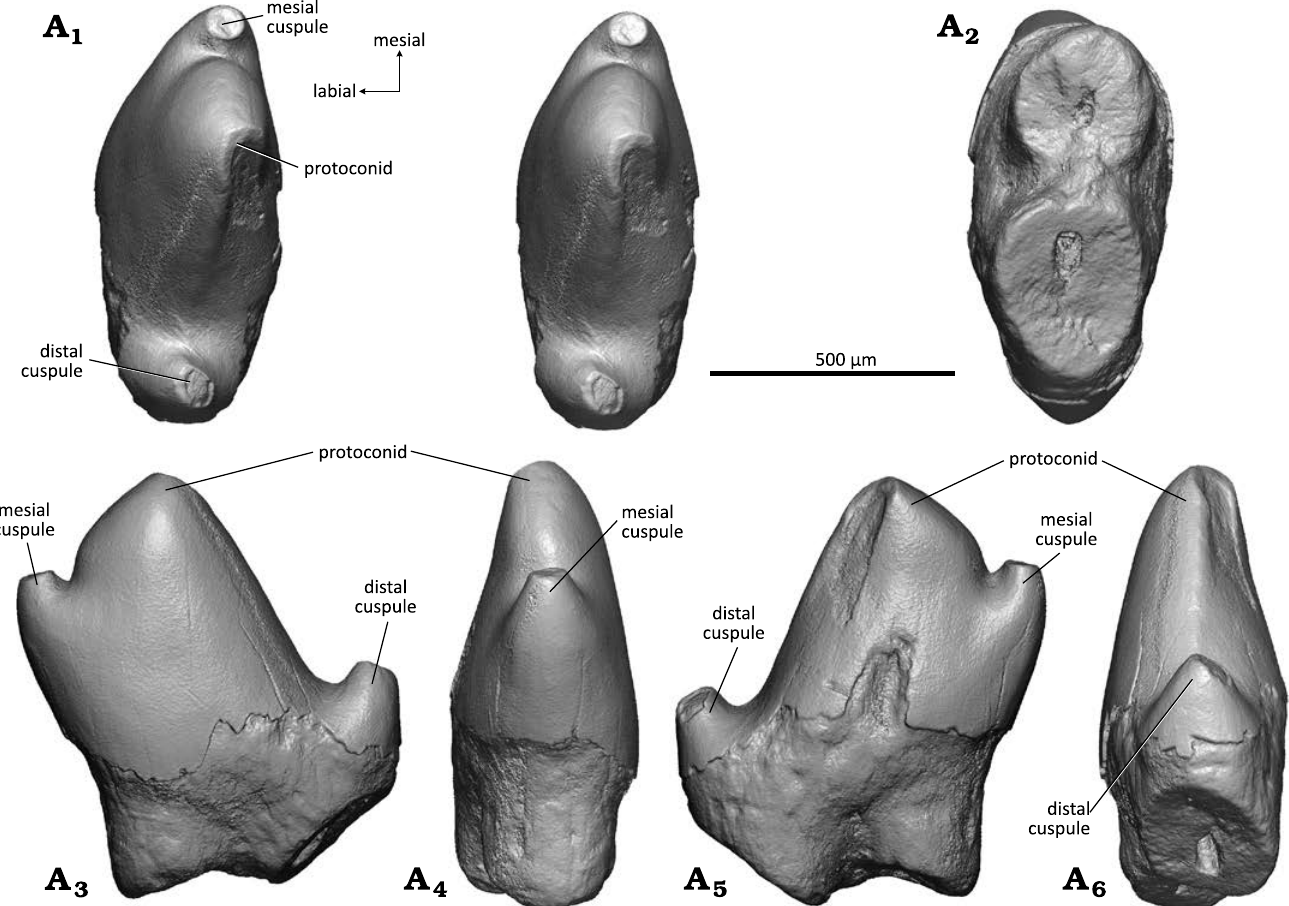
Fig. 10. Dryolestid mammal Beckumia sinemeckelia gen. et sp. nov., WMNM P82310 from Busche Quarry near Balve, North Rhine-Westphalia, Germany, Barremian–Aptian (Lower Cretaceous). Left lower p4 in occlusal (stereopair, A 1 ), ventral (A 2 ), labial (A 3 ), mesial (A 4 ), lingual (A 5 ), and distal (A 6 )